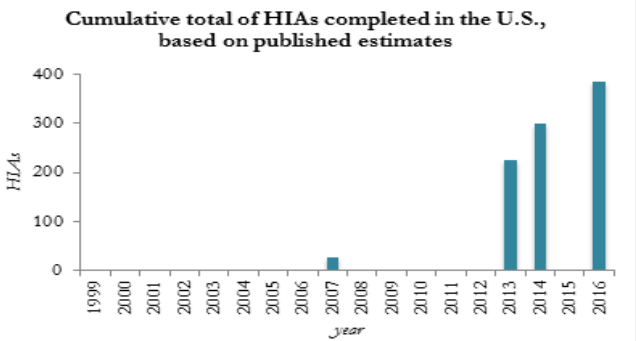
Figure 1. Since the completion of the first US HIA by the San Francisco Department of Public Health in 1999, the use of HIA has rapidly increased.